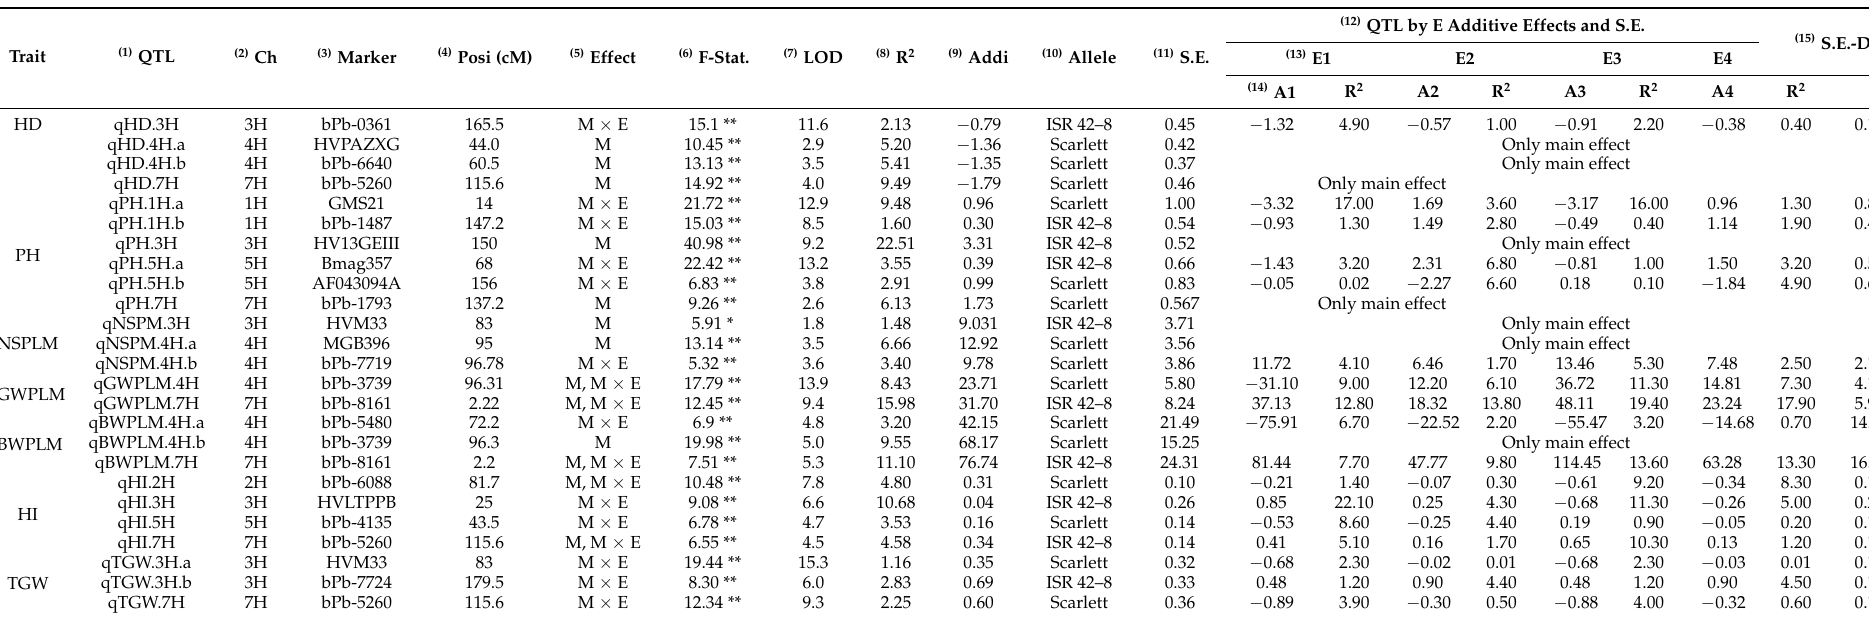
Table 4. Characterization of detected QTL as marker main- and/or by environments additive effects for measured traits under salinity